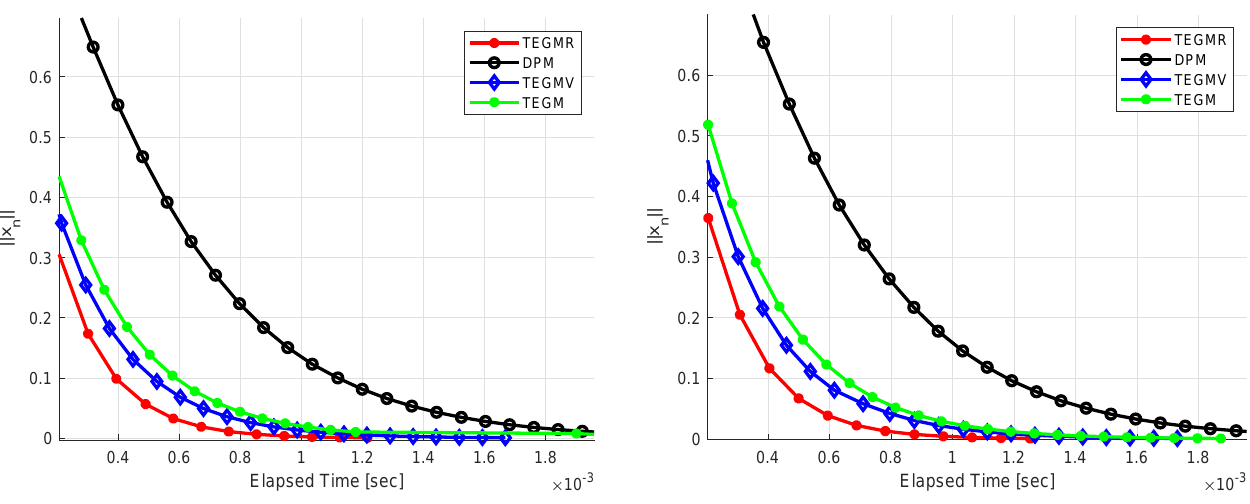
Figure 4. Example 2, Left : m = 5; Right : m =